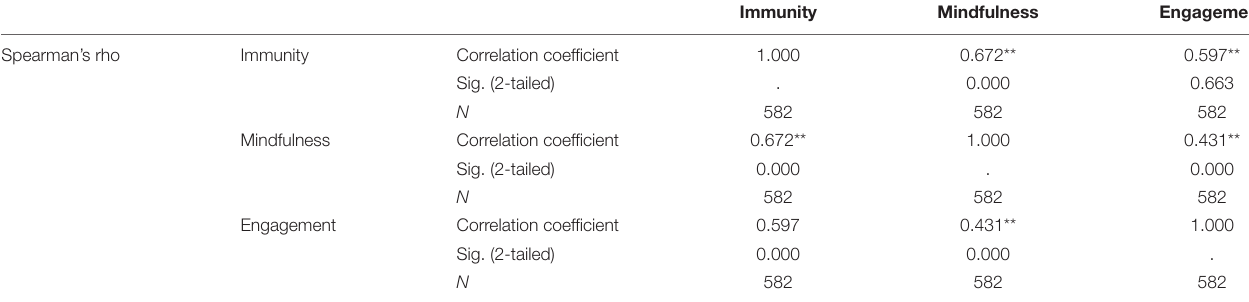
TABLE 4 | Correlations among teachers’ immunity, mindfulness, and